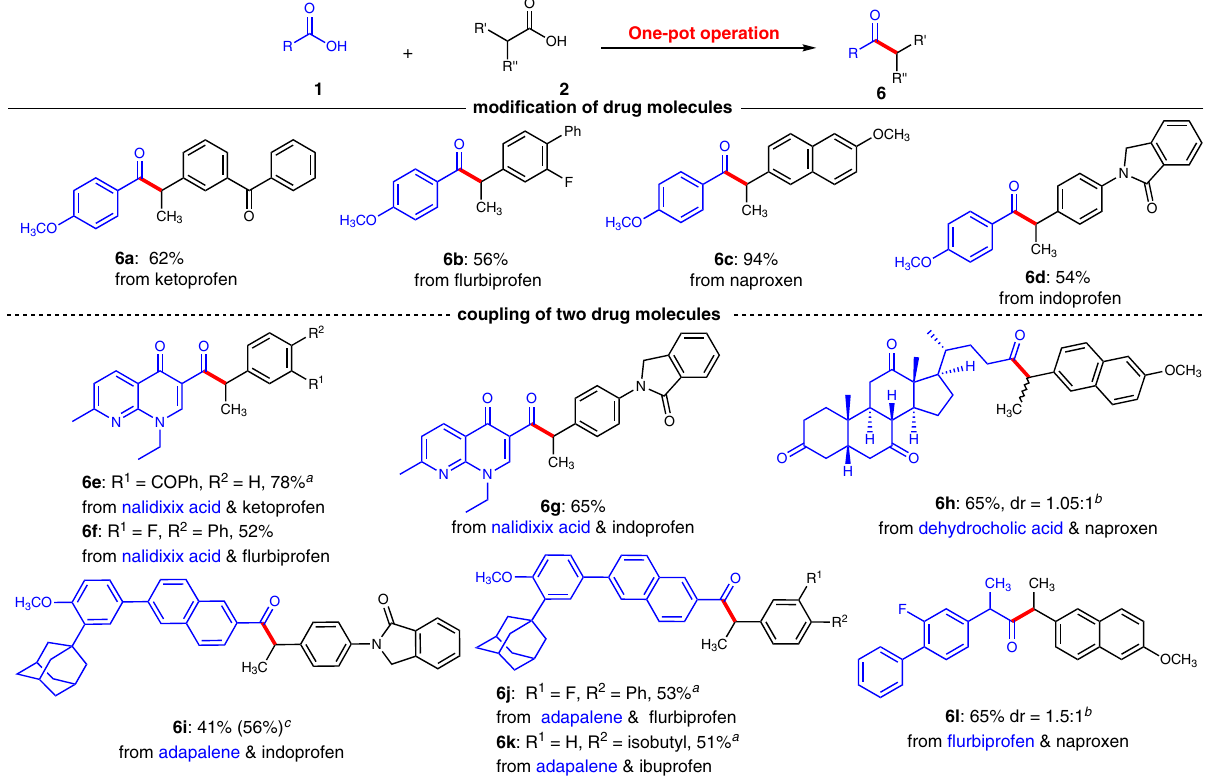
from nalidixix acid & ketoprofen 6f : R 1 = F, R 2 = Ph, 52% from nalidixix acid & flurbiprofen